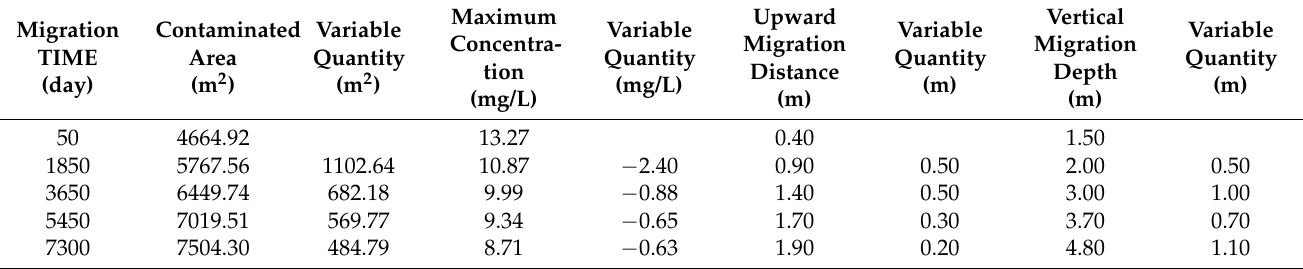
Table 4. Numerical simulation results for the transport model of the microconfined